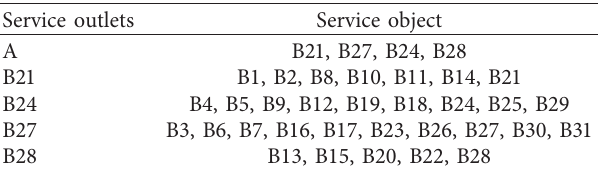
Table 6: Service object information of the supplier and distribution center in a static